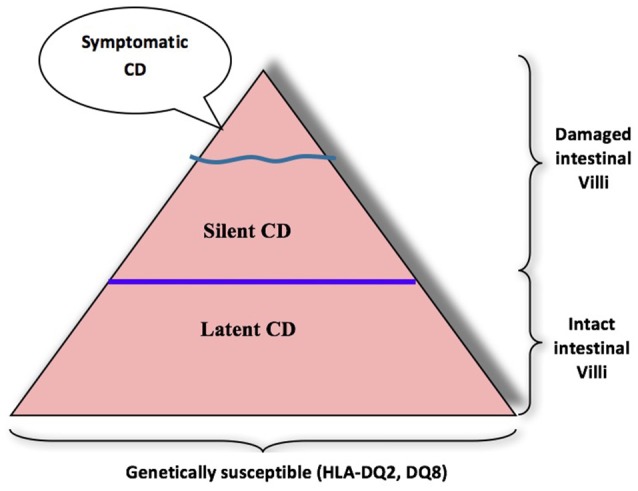
Iceberg for gluten-sensitive people.